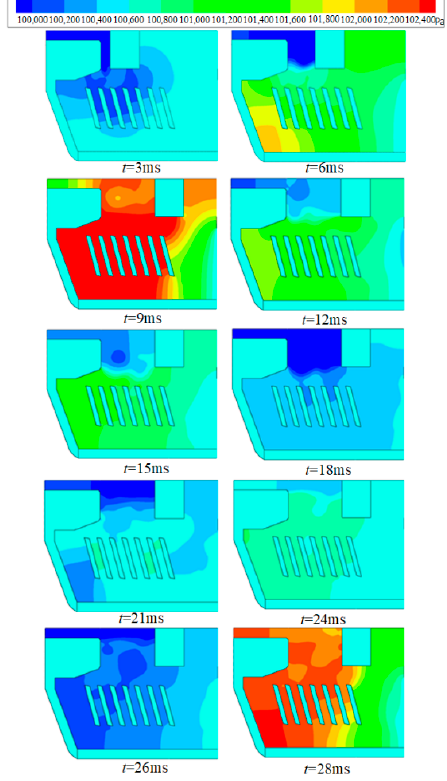
Figure 9. Pressure distribution of arc chamber (DC 1500 V).